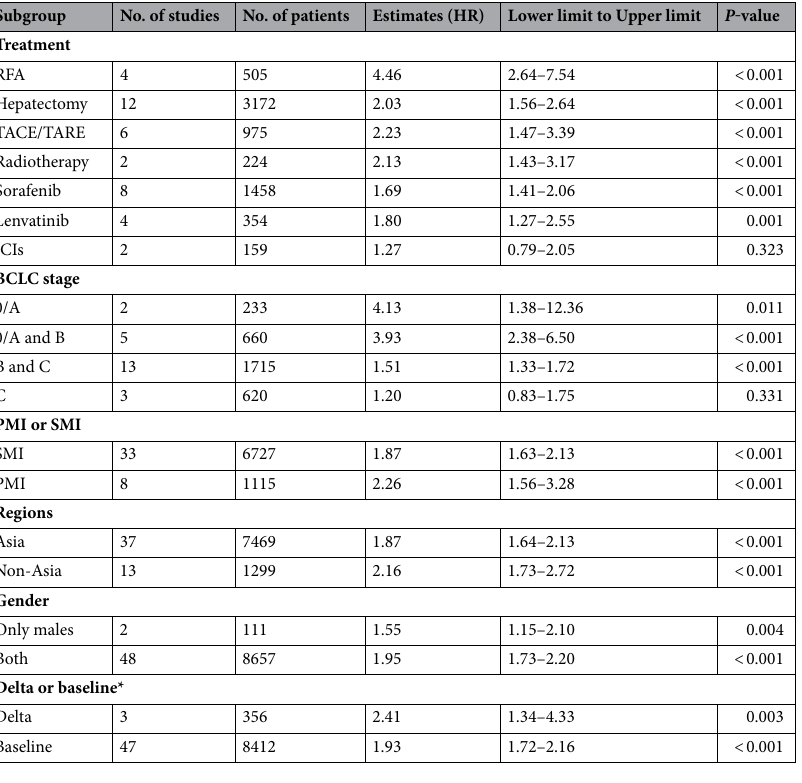
Table 1. Subgroup analyses of overall survival. ICIs immune checkpoint inhibitors, RFA radiofrequency ablation, TACE transarterial chemoembolization, TARE transarterial radioembolization, BCLC